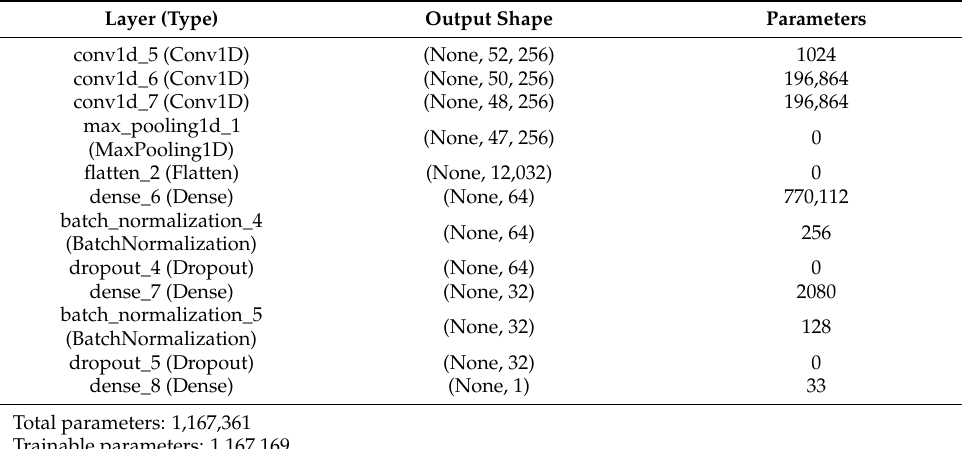
Table 3. Architecture and parameter settings of the CV-CNN